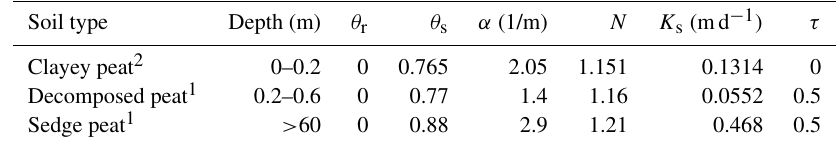
Table 1. Mualem–van Genuchten parameters and saturated hydraulic conductivity for each soil